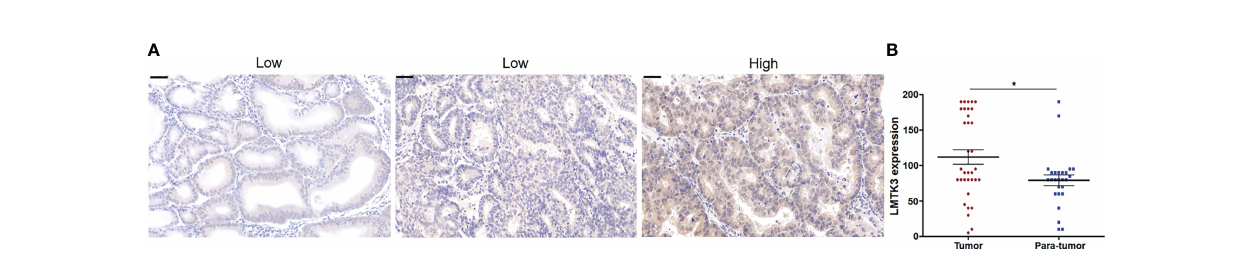
FIGURE 1 | The cytoplastic expression of LMTK3 with signi fi cant difference between EEC tumor and para-tumor groups of tissue microarray. (A) Low and high staining of LMTK3 in endometrioid adenocarcinoma tissues; scale bar: 50 µM. (B) Scatter plot of cytoplastic LMTK3 expression with signi fi cant difference between EEC tumor and para-tumor groups, * P < 0.05.